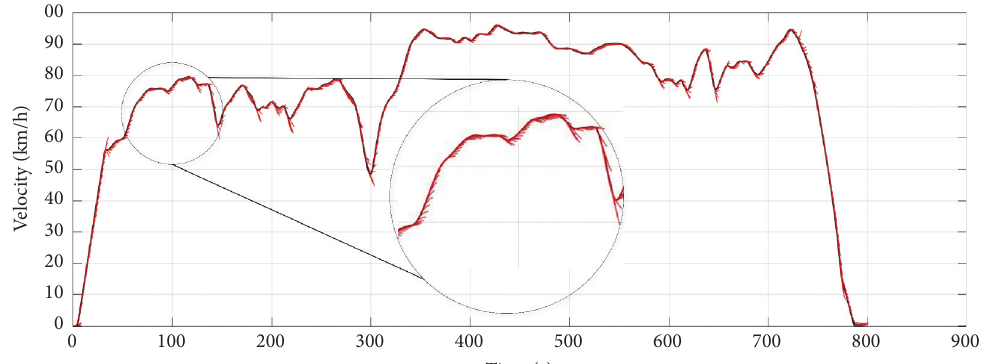
Figure 9: Prediction